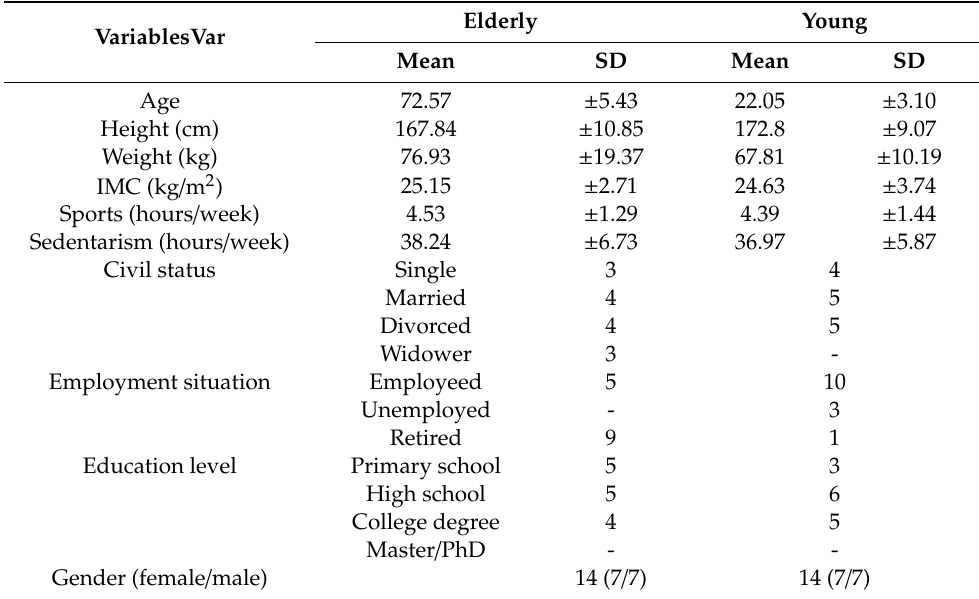
Table 1. Description of the